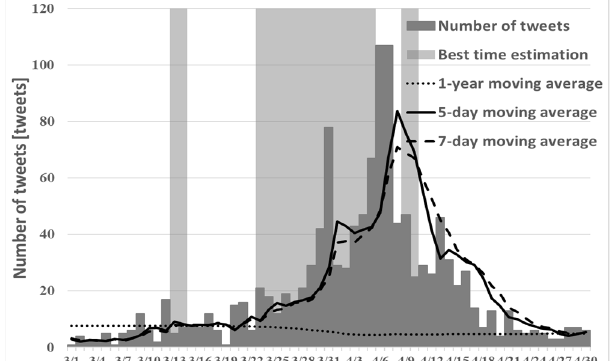
Figure 3. Kyoto in 2019.